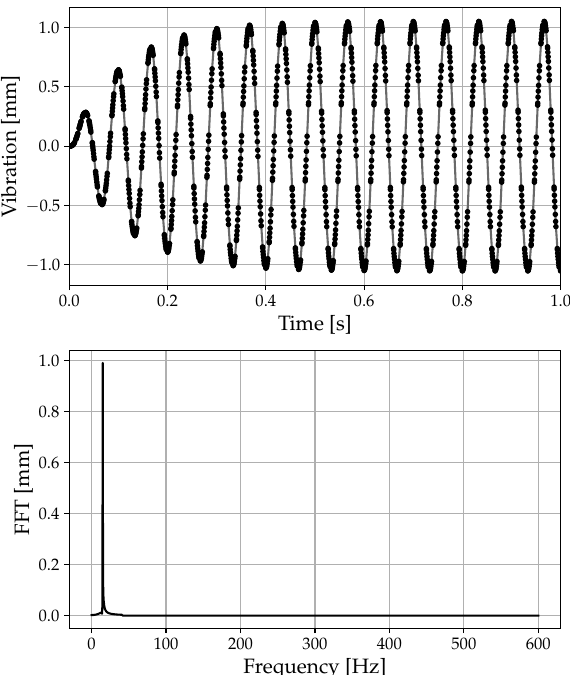
Figure 4. Example of deflection: 9000 to 9500 RPM, f r = 15 Hz , A = 1 mm: amplitude response and deflection FFT.